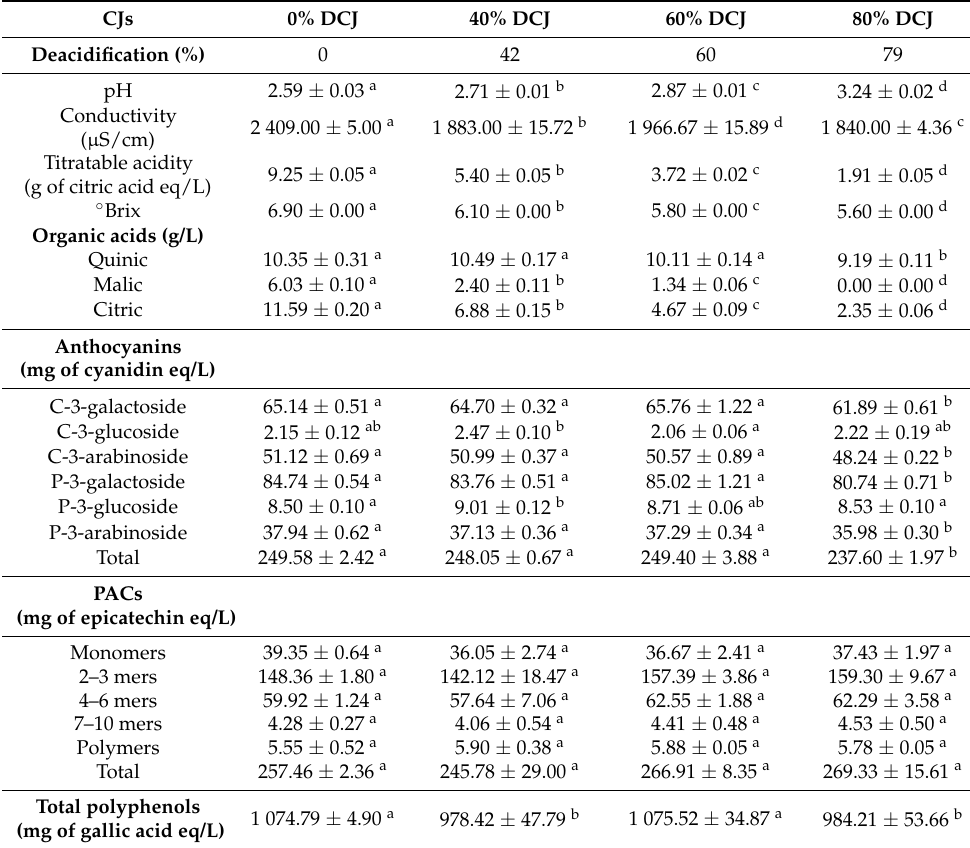
Table 1. Physicochemical characteristics of the 0, 40, 60, and 80% DCJs. Data on the same line with different letters are significantly different at a probability level of 0.05. CJs 0%